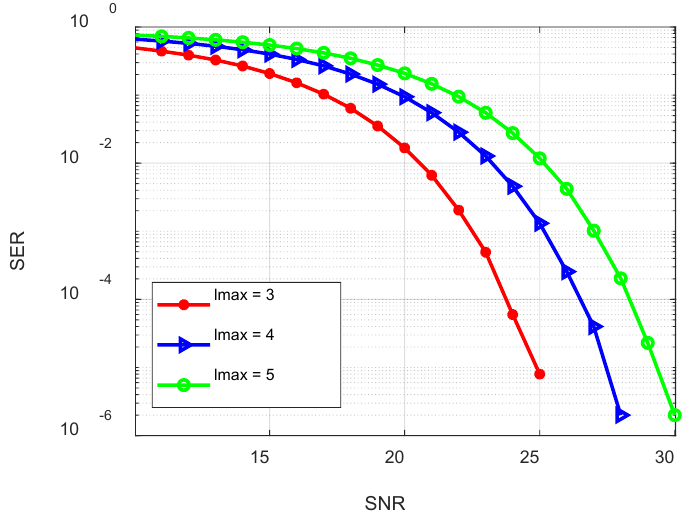
Figure 6. Error performance at different LED cores. In order to study the influence of the dimming level on the error performance of the ML-MTSC scheme proposed in this paper, we provide SER curves with different dimming levels under the condition of N = 2, l max = 4, and h 1 : h 2 = 1 : 1. The curves are shown in Figure 7 when the dimming level γ is 1/3, 1/4, and